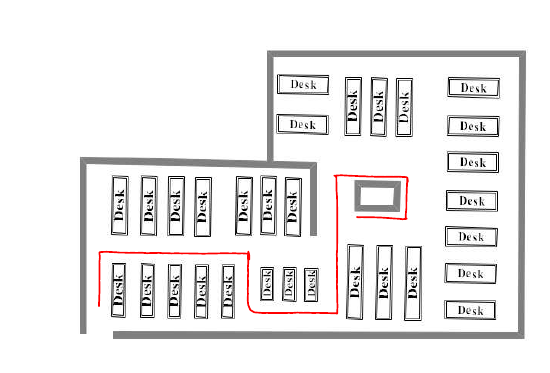
Figure 11. Positioning result for FPF.